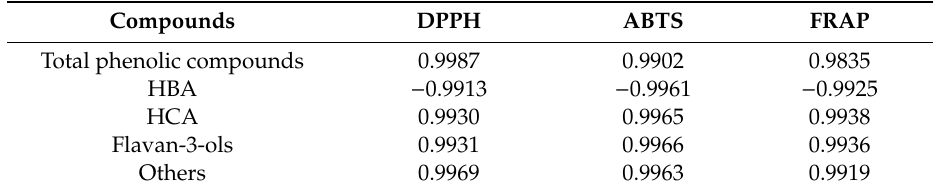
Table 5. Correlation coe ffi cients ( p < 0.001) obtained between phenolic content and antioxidant assays in banana passion fruit. Compounds DPPH ABTS FRAP Total phenolic compounds